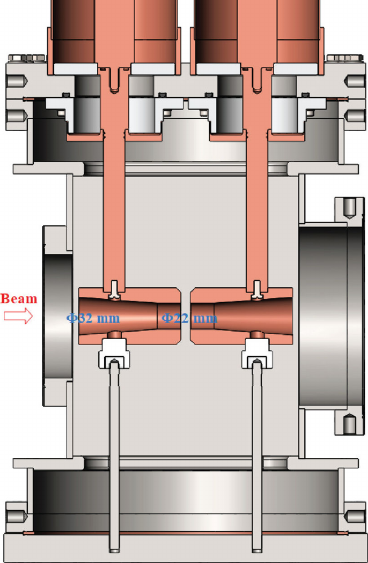
FIG. 23. Side cross section of the